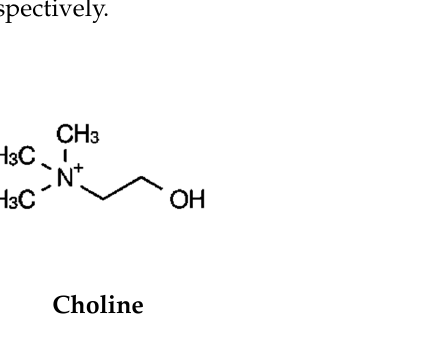
Figure 1. Chemical structure of choline (2-hydroxyethyl(trimethyl)ammonium) and Amb4269951 (4-methoxy-6,6-dimethyl-5-(2-oxo-2-(4-pentylphenyl)ethyl)-5,6,7,8-tetrahydro-[1,3]dioxolo [4,5-g]isoquinolin-6-ium iodide).